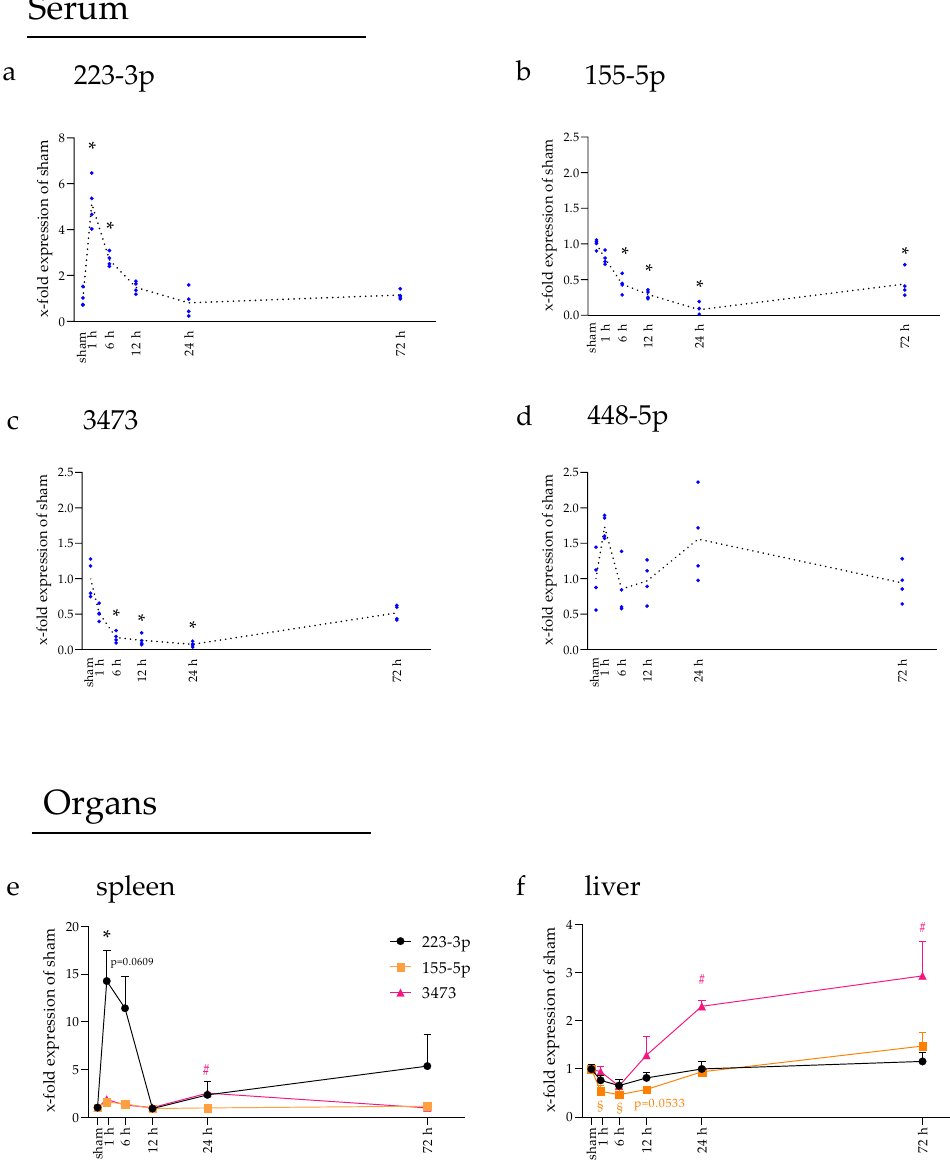
To observe if the tMCAo injury could also lead to an alteration in the studied miRNAs in the spleen and liver, RNA was isolated and gene expression studies were conducted. In the spleen, upregulation of miR-223-3p expression was observable after 1 h (ad- justed p -value, 0.0107) and 6 h ( p = 0.0609), which significantly decreased after 12 h (6 h vs. 12 h, p = 0.0482) and never reached a significant threshold again (all following time points > 0.9). The expression of miR-3473 increased after 24 h compared to sham ( p = 0.0125) and decreased again after that (24 h vs. 72 h, p = 0.0108). No alteration in miR-155-5p expression could be observed in the